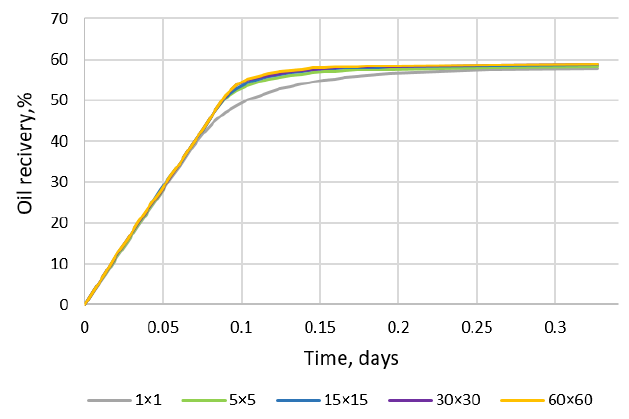
Figure 10. Oil recovery comparison.